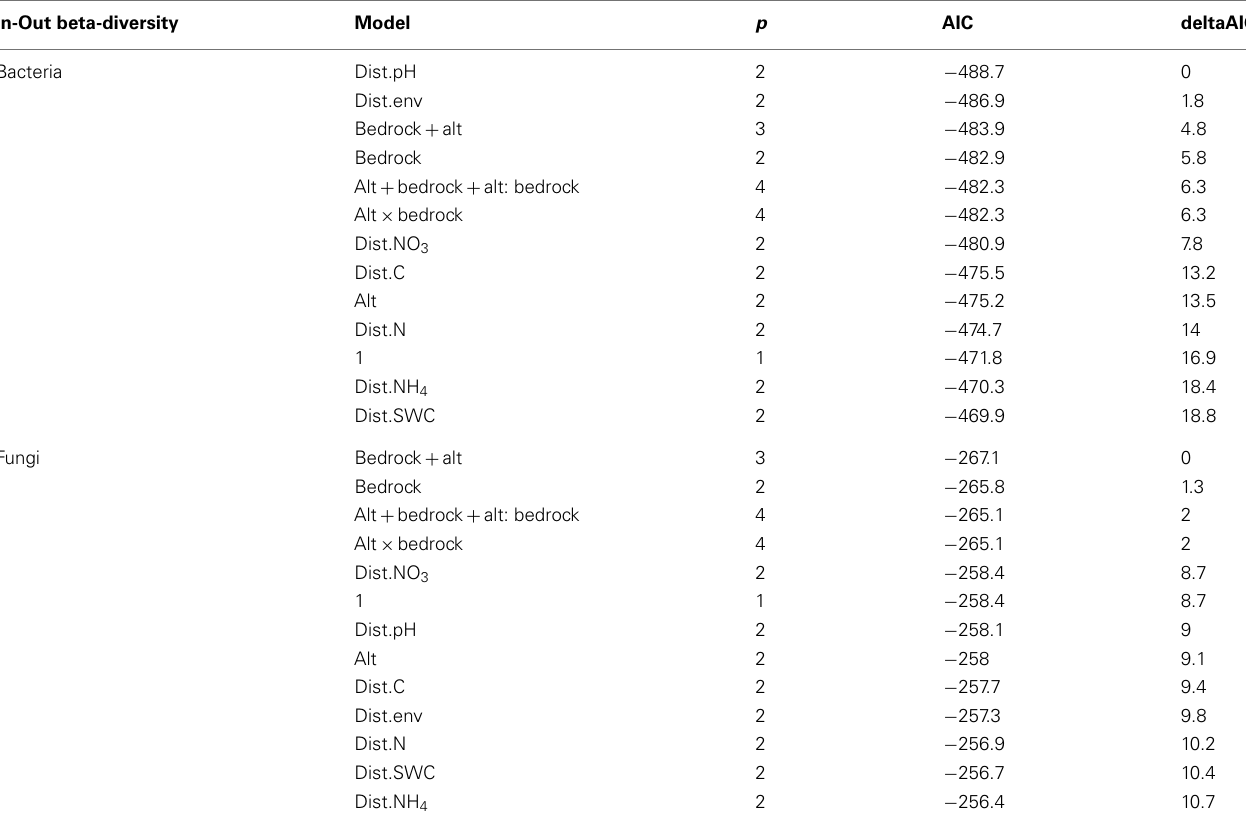
TableA2 | Model selection of fixed effects and interactions explaining the variation in bacterial and fungal In-Out beta-diversity. In-Out beta-diversity